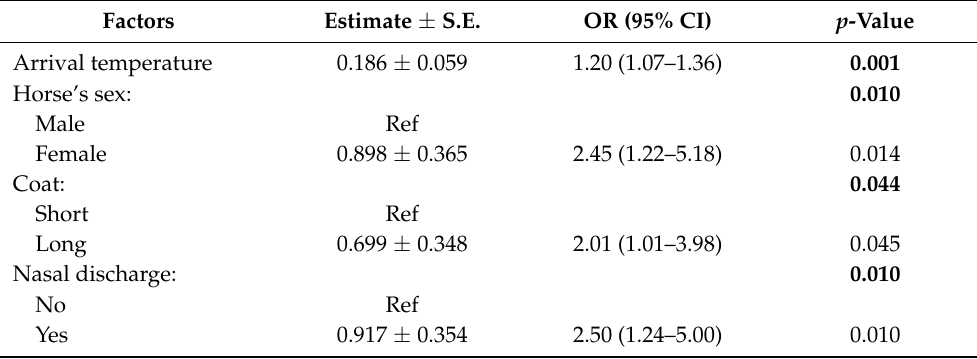
Table 11. Lacrimal discharge—final multiple regression model for the dummy dependent variable of presence/absence of lacrimal discharge in handled horses at arrival at the slaughterhouse. Data are presented as estimates and standard error (S.E.) of the effect, odds ratio (OR), confidence interval (95% CI), and p -value. Bold p -values refer to the statistical significance of the predictive variable in the model; the significance of a category against the reference is reported in regular